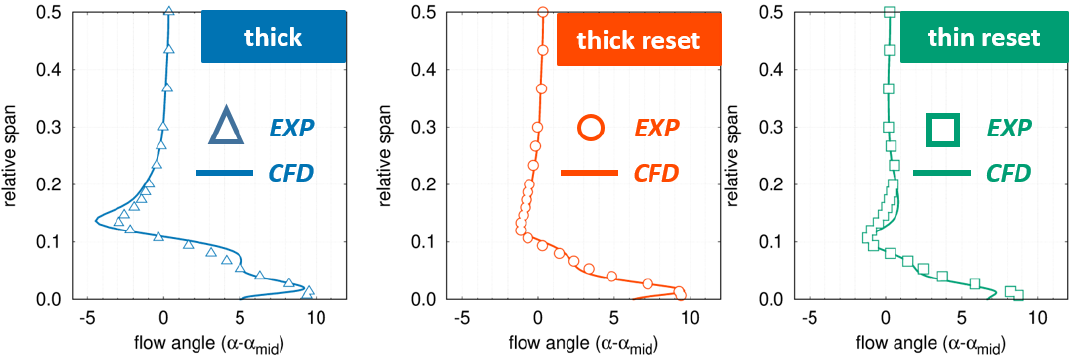
Figure 17. “Snaked” blade robustness: measured and computed spanwise distributions of the exit blade-to-blade angle at varying inlet conditions